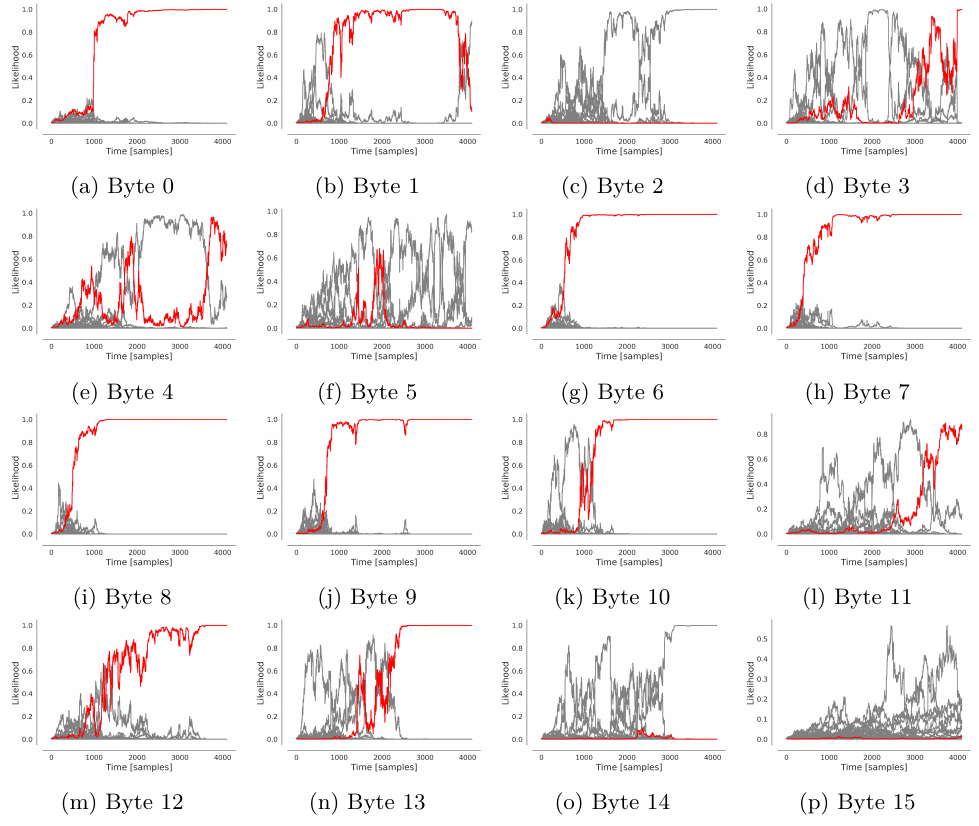
Figure 38: Recovery of the 16 key bytes in the last round of AES-CTR on Arduino Uno with blind SCA, using 4 096 traces. The red lines indicate the correct